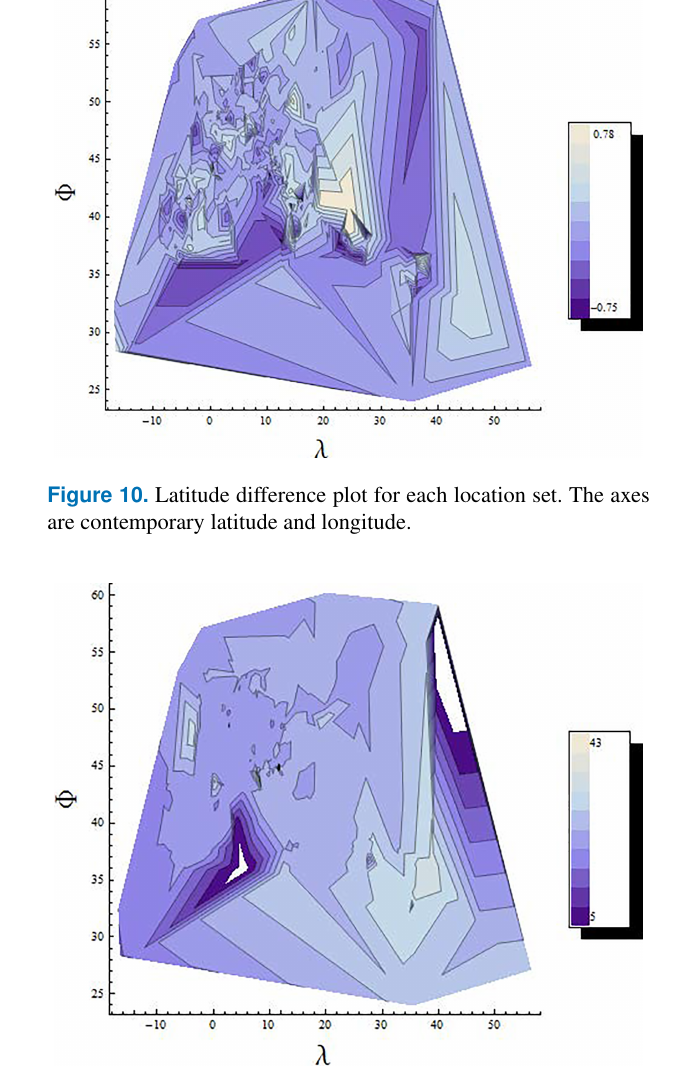
Table 2. Statistical analysis and tests for f statistical distributions for the Riccioli set: µ is the mean, σ is the standard deviation, RMSE is the root mean square error, Cramér–von Mises P value